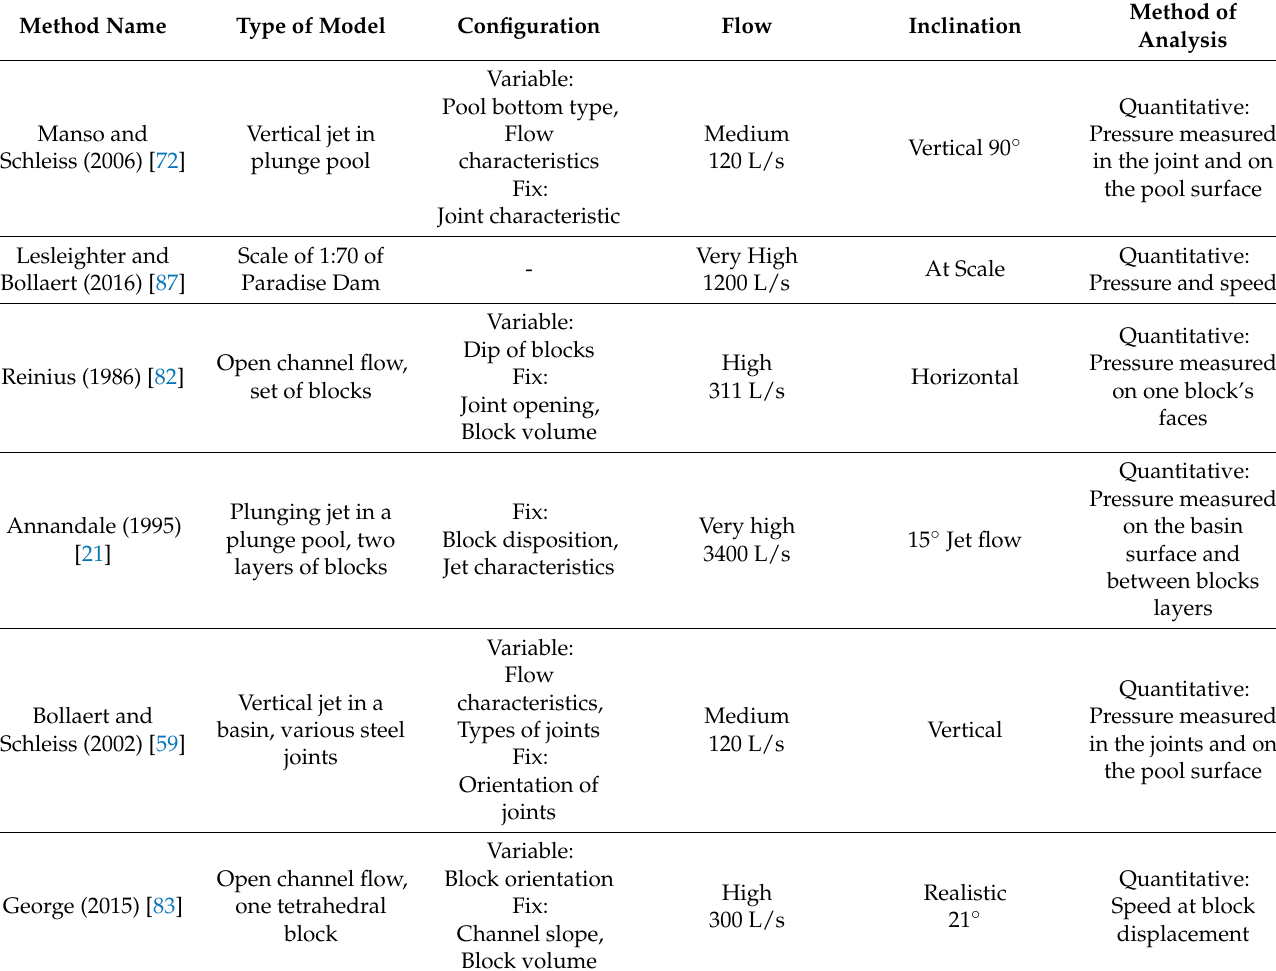
Table 13. Hydraulic geometrical characteristics of the